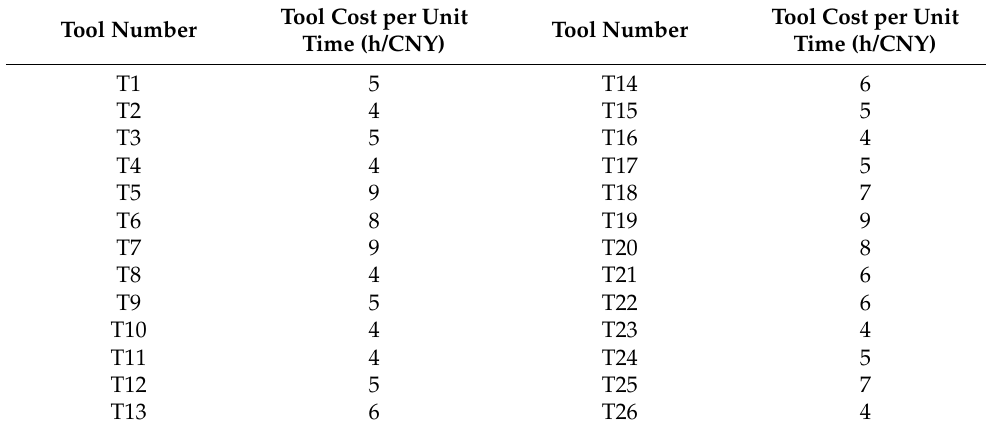
Table 6. Tool cost per unit